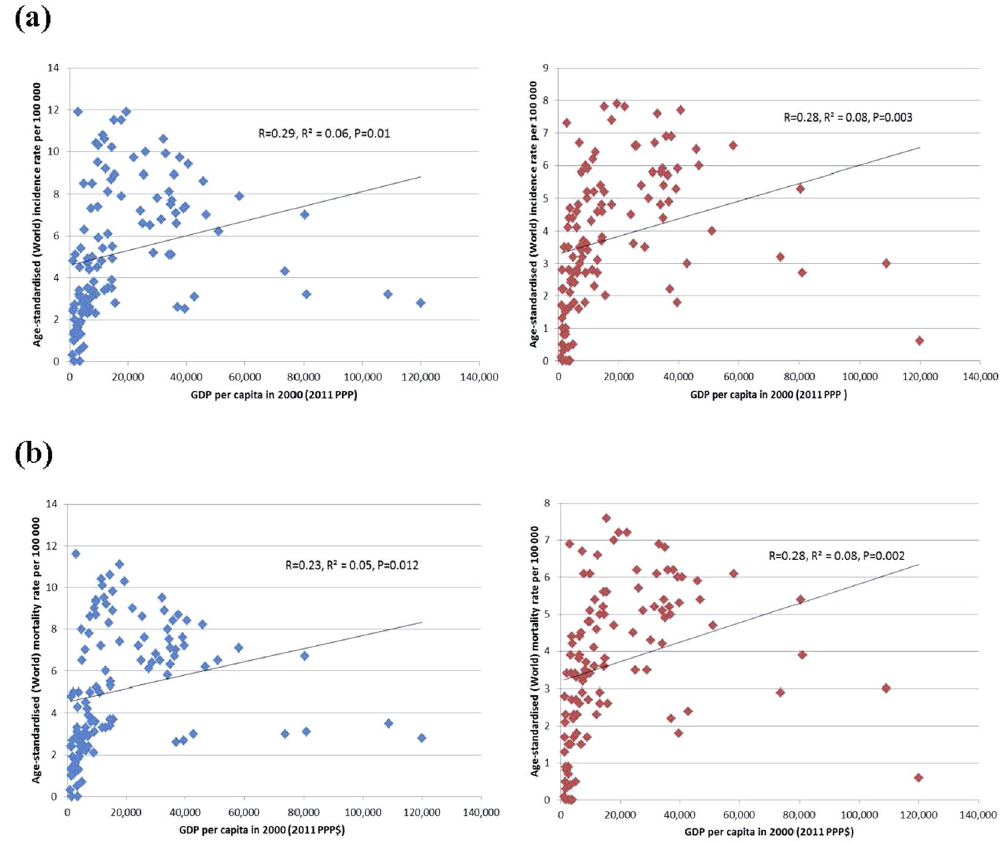
Figure 2. ( a ) Correlation between age-standardised mortality of pancreatic cancer in 2012 and Human Development Index (HDI) in 2000 in men (left) and women (right); ( b ). Correlation between age-standardised mortality of pancreatic cancer in 2012 and Gross Domestic Product (GDP) per capita in 2000 in men (left) and women